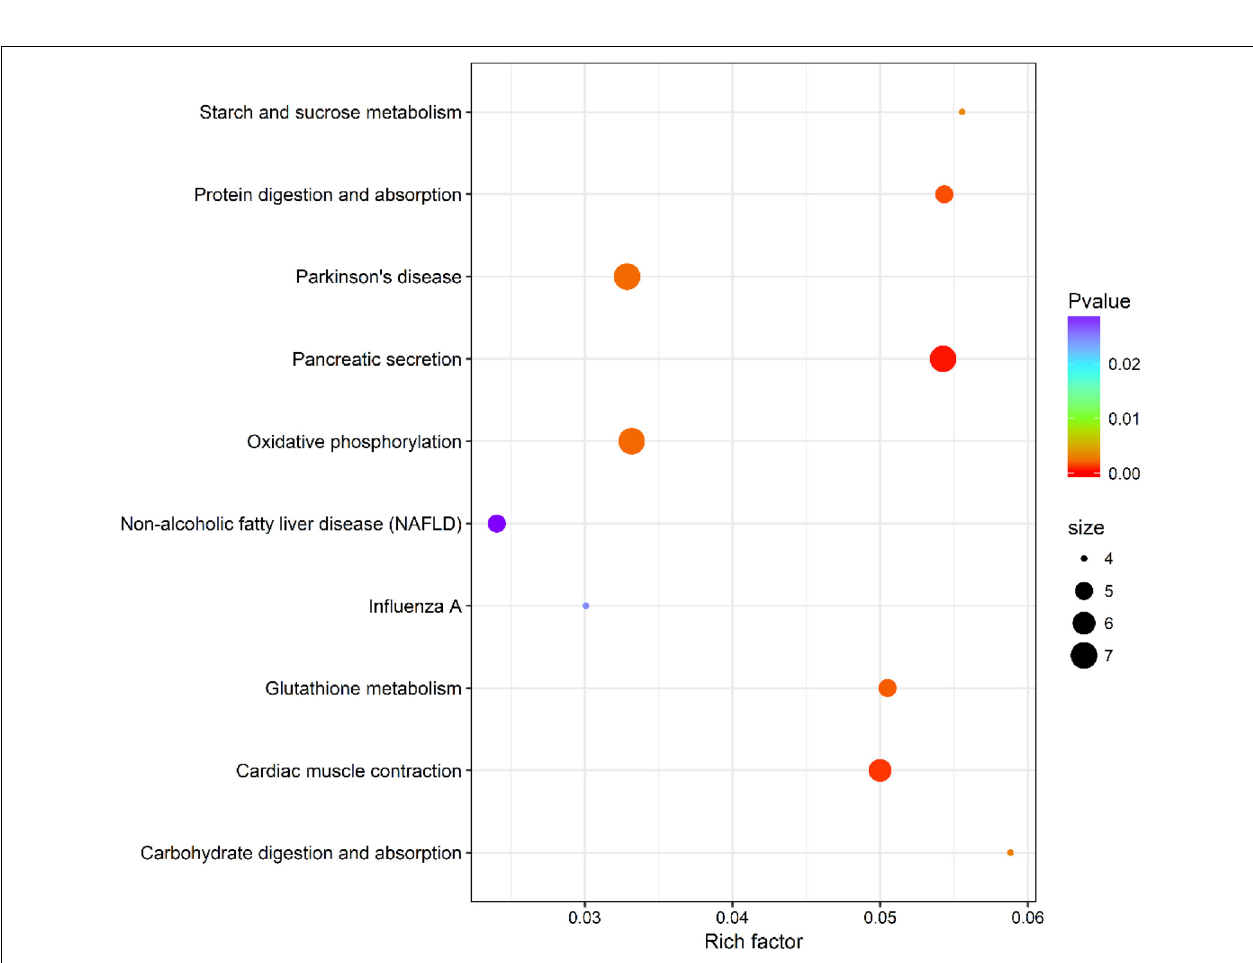
Frontiers in Physiology |